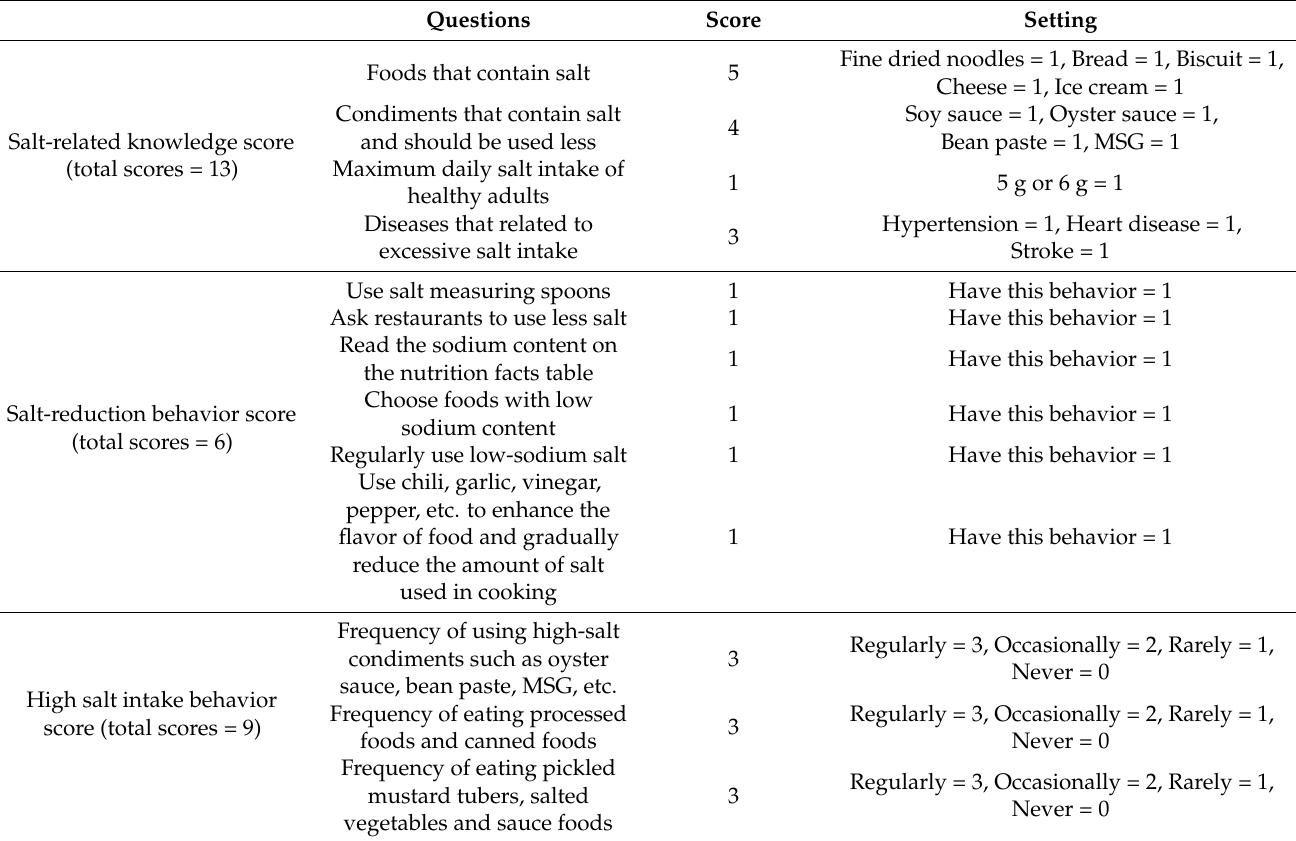
Table 1. The calculation method of salt-related knowledge and behavior